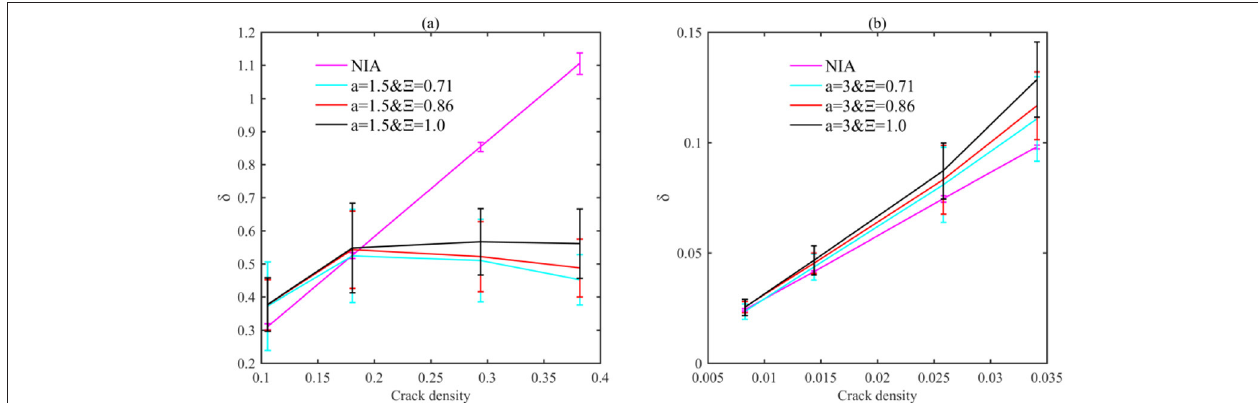
FIGURE 9 | Anisotropic parameters δ , as the function of fracture density, are presented for various rock samples. The centers of the bars correspond to the averaged numerical anisotropic parameter. The numerical result bars are in line with those in Figure 6 . In the legend, 4 is the aspect ratio for the ellipse boundary of the fracture clustering, while a = 1.5 (A) and 3 (B) correspond to the long and short fractures, respectively.